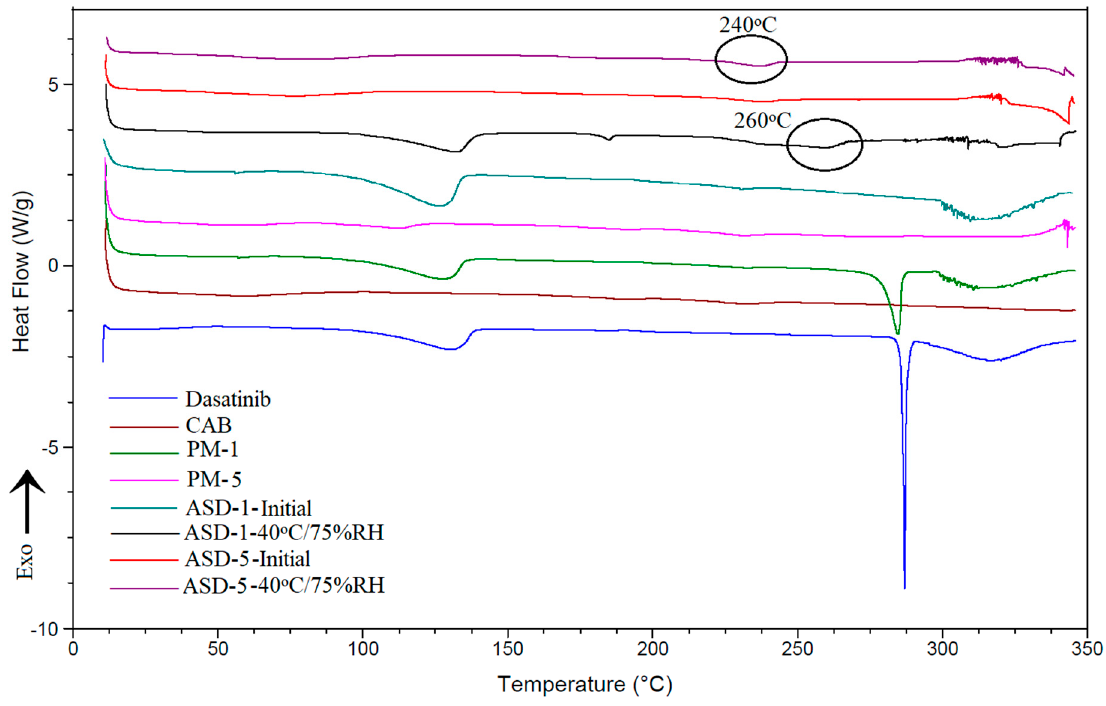
Figure 5. DSC thermograms of PM − 1, PM − 5, ASD − 1, ASD − 5 initial and 40 °C/75% RH